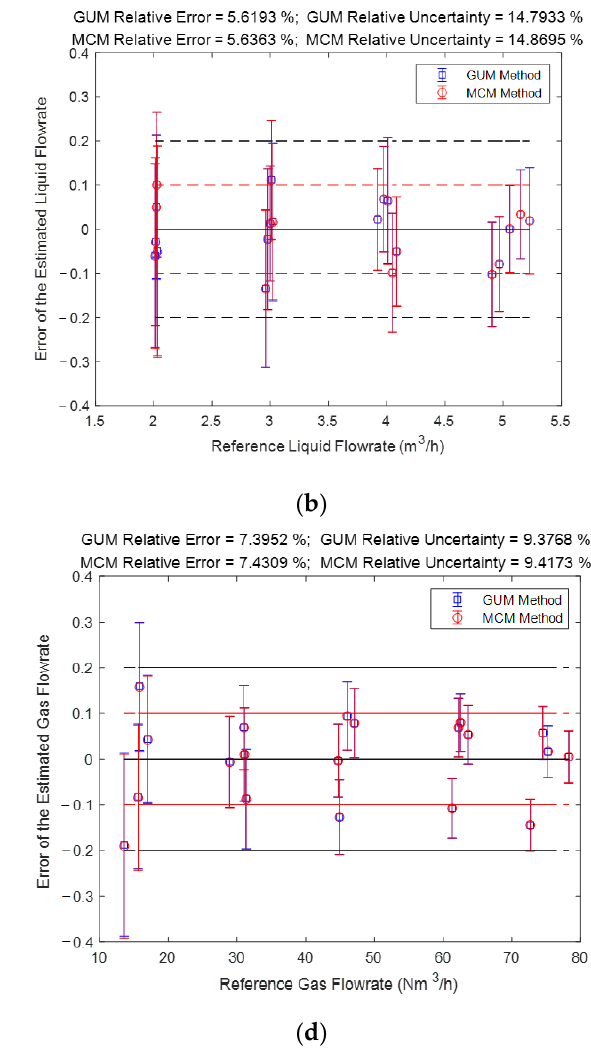
Figure 8. The prediction results of the liquid and gas flowrates of the “Cap + CC” method: ( a ) absolute error of the liquid flowrate; ( b ) relative error of the liquid flowrate; ( c ) absolute error of the gas flowrate; ( d ) relative error of the gas flowrate. (The central black line denotes the ideal case with zero error, the upper and lower red lines denote the 10% relative error range, and the upper and lower black lines denote the 20 % relative error range. The line segments denote the standard uncertainty whereas the distance between the point and the central black line denote the error. More information can be found in Section 2.4.2)